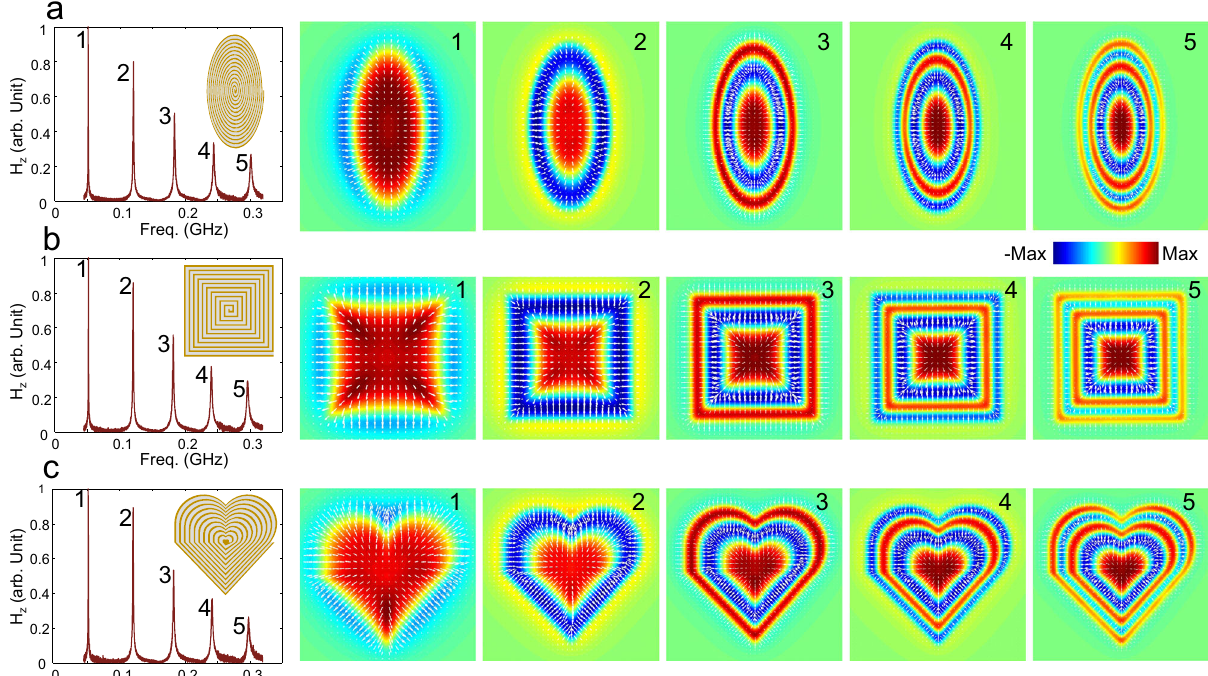
Fig. 5 LSP skyrmions with robust properties against continuous shape deformations of the space-coiling meta-structure. Measured near-equidistant multi-resonant response spectra, geometry schematics (left-most panels) and vector fi eld con fi gurations with out-of-plane components illustrated by colors and in-plane components by arrows (right 5 panels) for different geometries: ( a ) ellipse, ( b ) square, ( c ) heart-shape. Max in the color bar represents the maximum amplitude of the fi eld